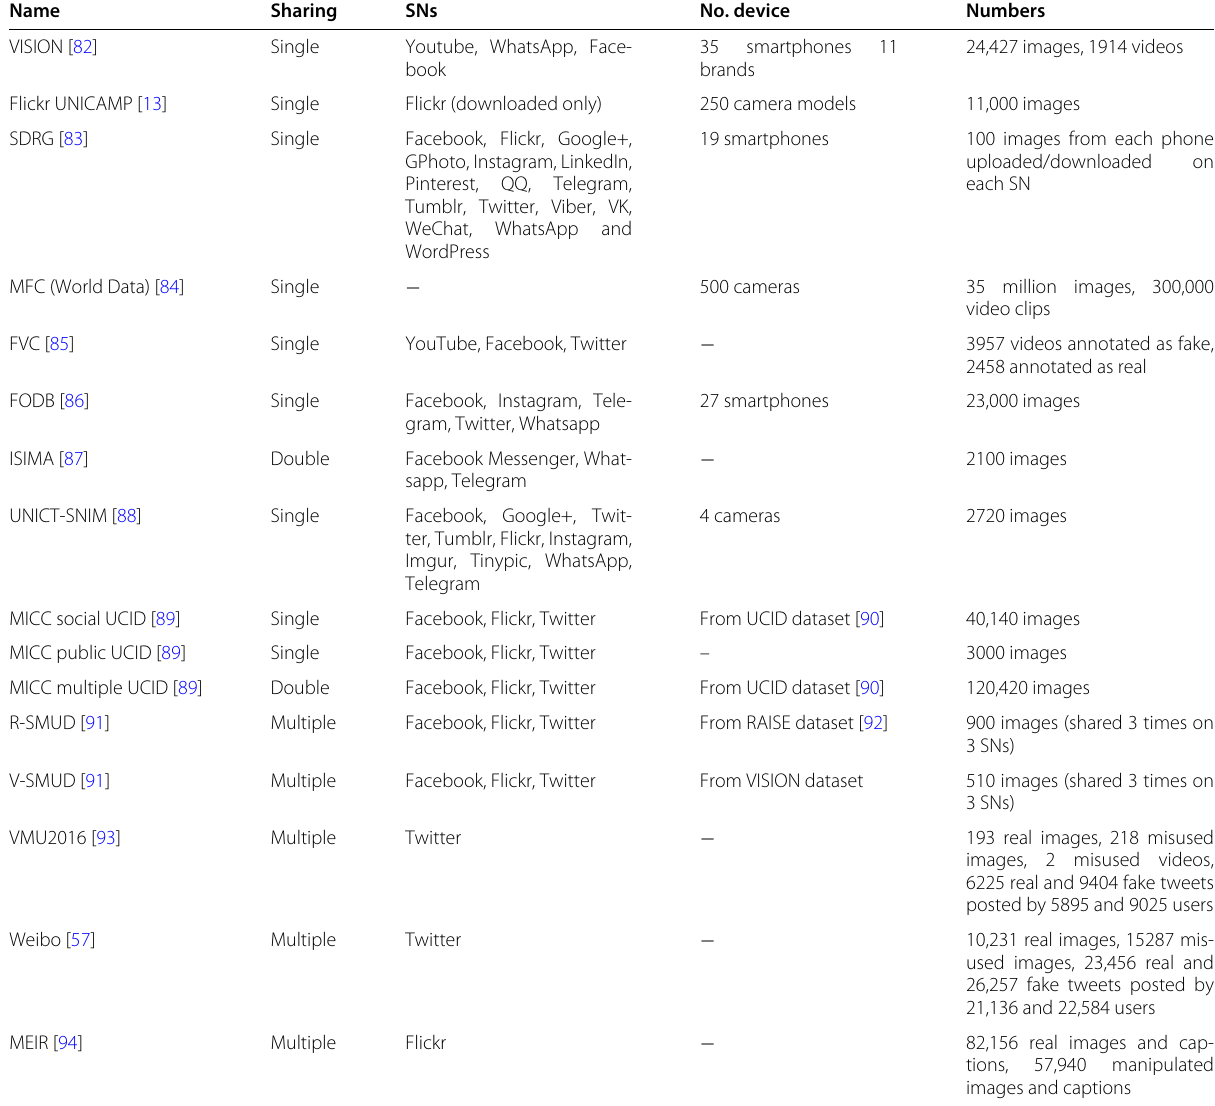
Table 7 Overview of the datasets on shared